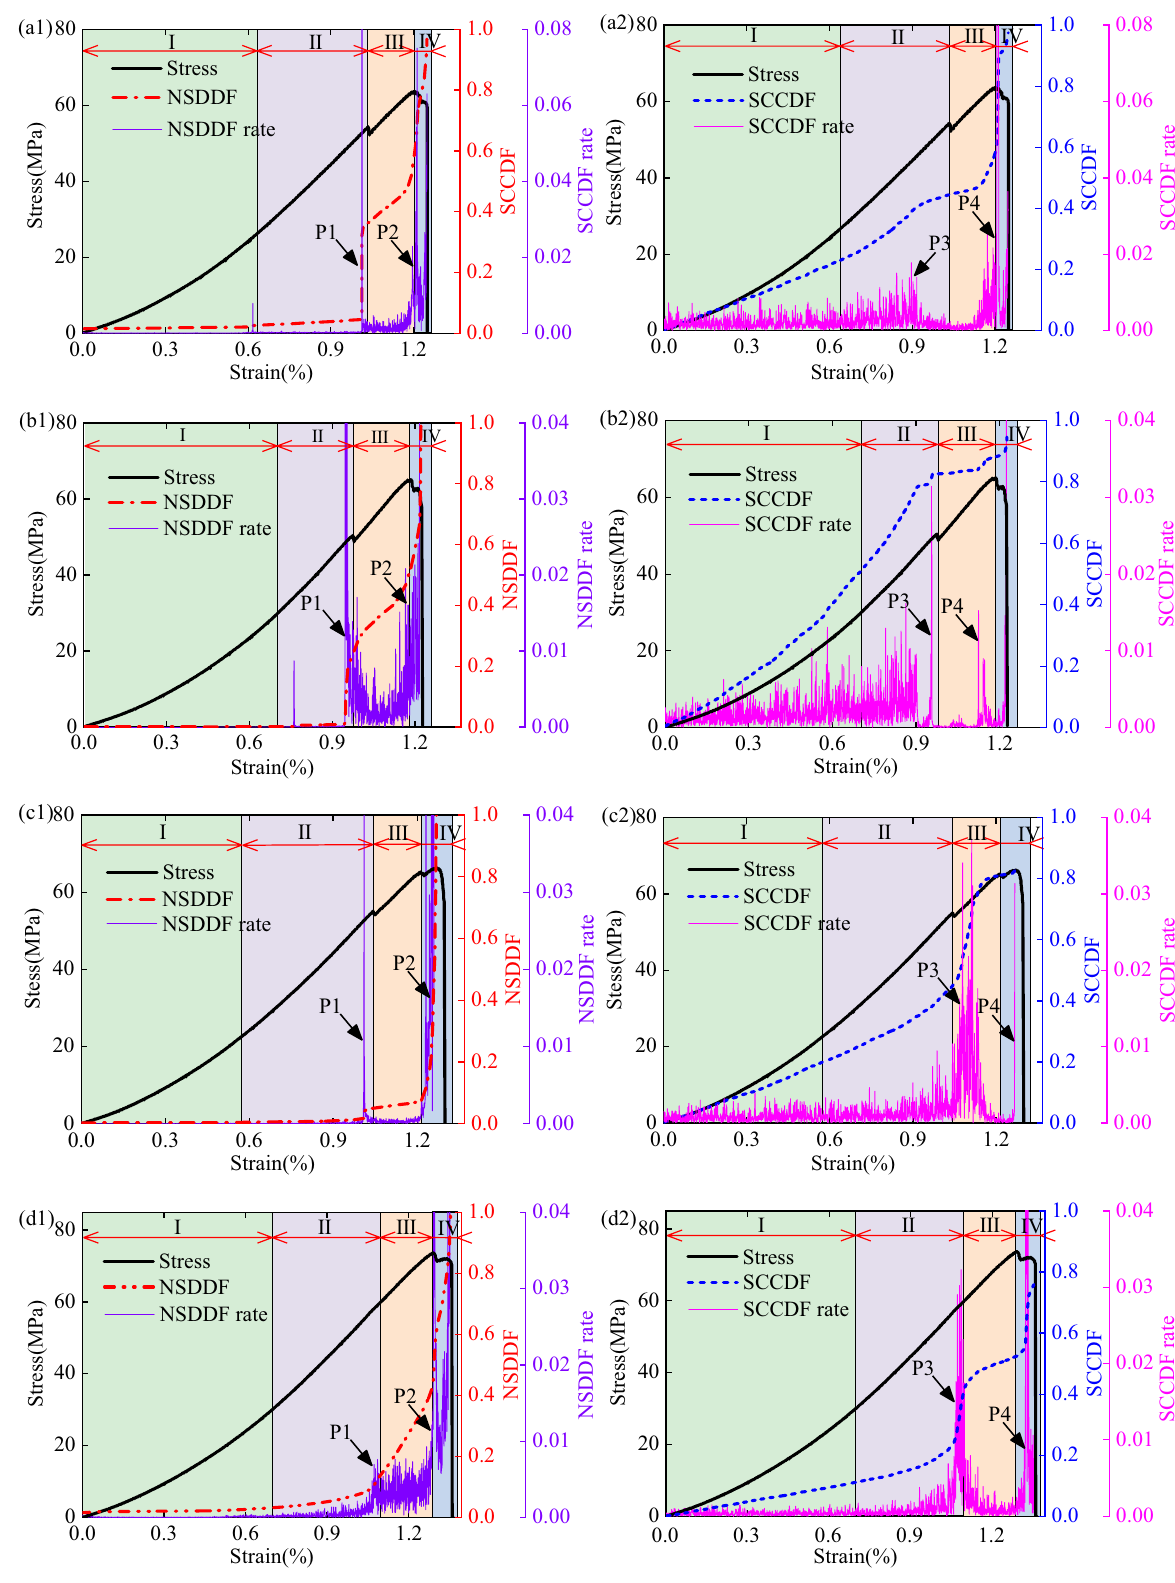
Figure 9. Variations in the NSDDF and SCCDF with loading for the specimen No. 0-1 ( a1 , a2 ), No. 30-1 ( b1 , b2 ), No. 45-1 ( c1 , c2 ), and No. 60-1 ( d1 , d2